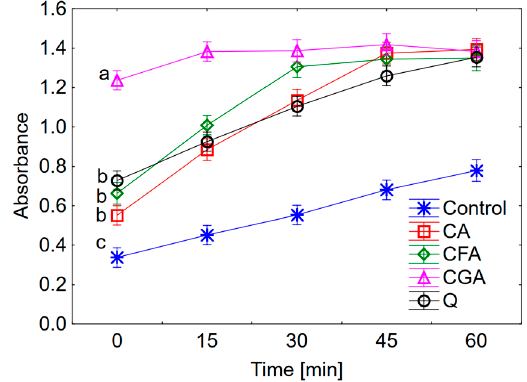
Figure 2. The effect of selected phenolic compounds (0.25 µ M) on the oxidation of trolox. CA: cichoric acid, CFA: caffeic acid, CGA: chlorogenic acid, Q: quercetin. The same letters for particular compounds indicate no significant difference (Tukey test, p < 0.05).